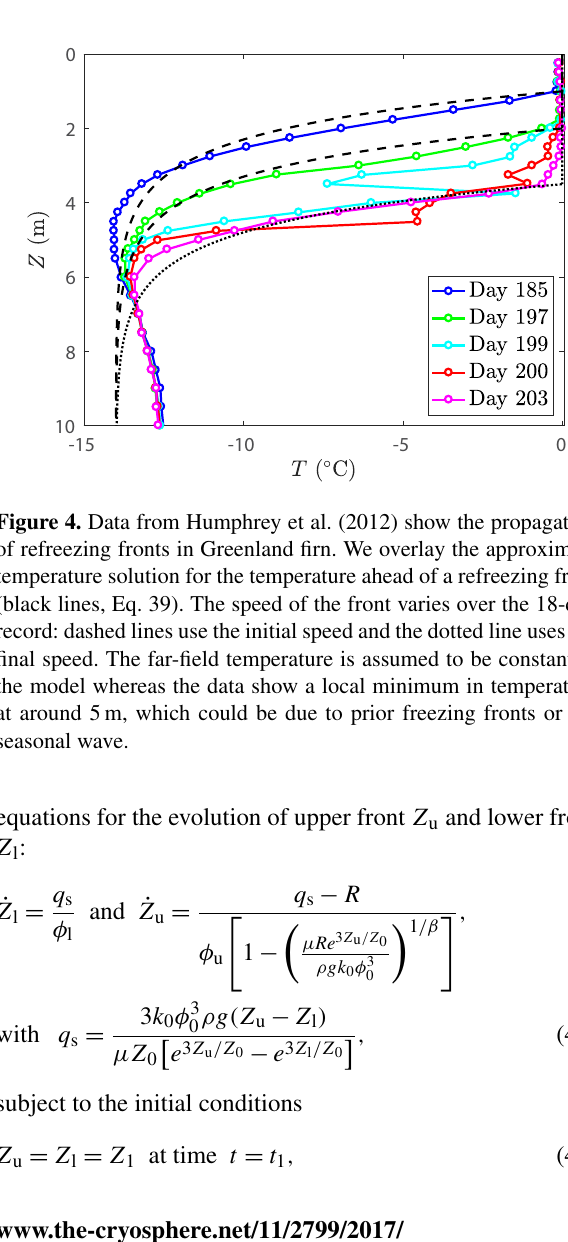
Figure 3. Evolution of a refreezing front at three instances of time, partitioned between the three components of the enthalpy. The green, red, and yellow colors show the porosity, saturation, and temperature profiles, respectively. The dashed lines show the approximate analytical solutions described in Appendix C. The temperature is made nondimensional by T = T m + (T ∞ − T m ) ˆ T and the parameters are φ 0 = 0 . 4 , and R = 0 . 54, along with other values in Table 1.